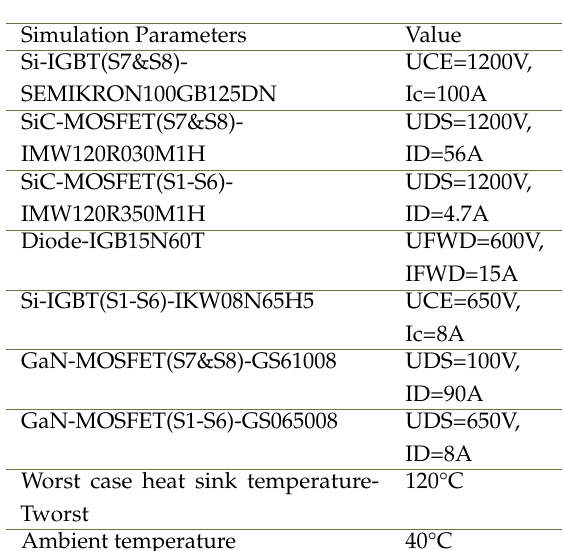
Fig. 6. (a) Load current THD (b) CMLC with varying C pv Table 2. Simulation